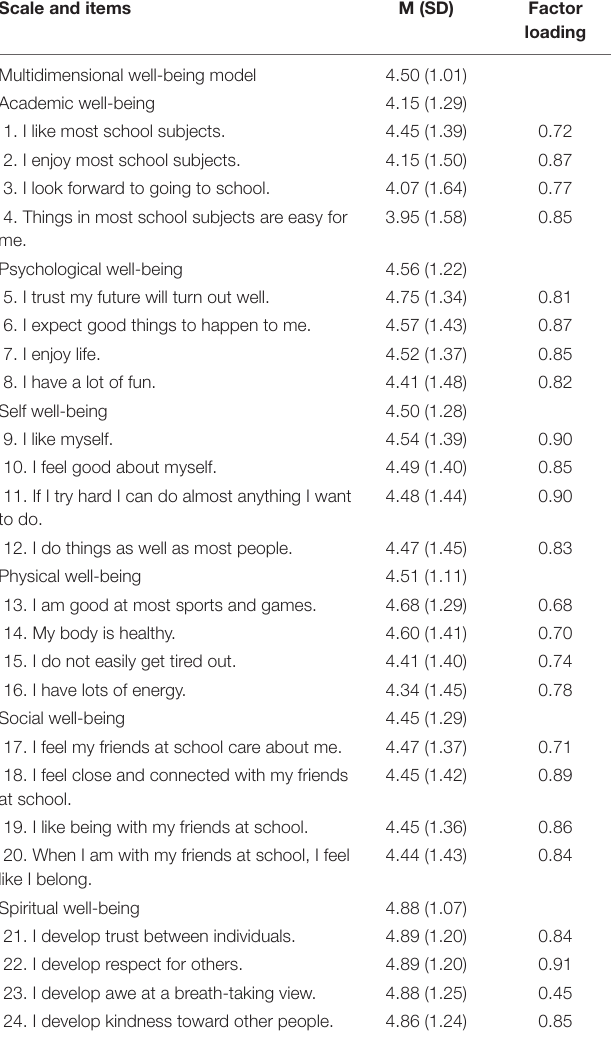
TABLE 2 | Multidimensional well-being items and factor loadings.